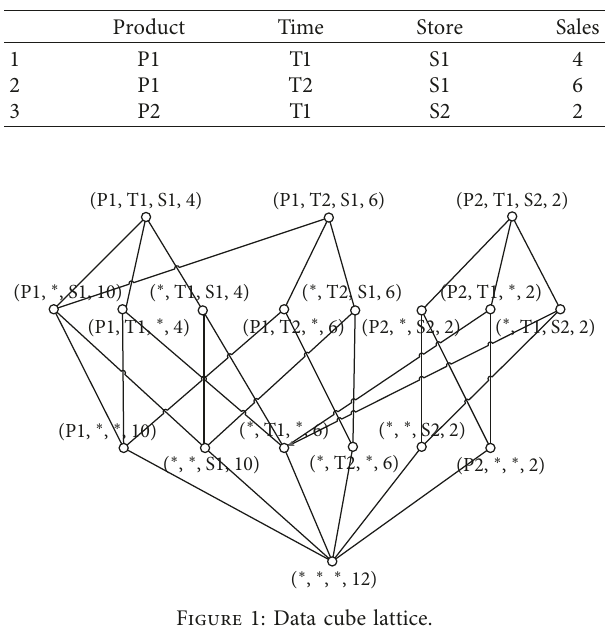
Table 1: Base table of product sales.